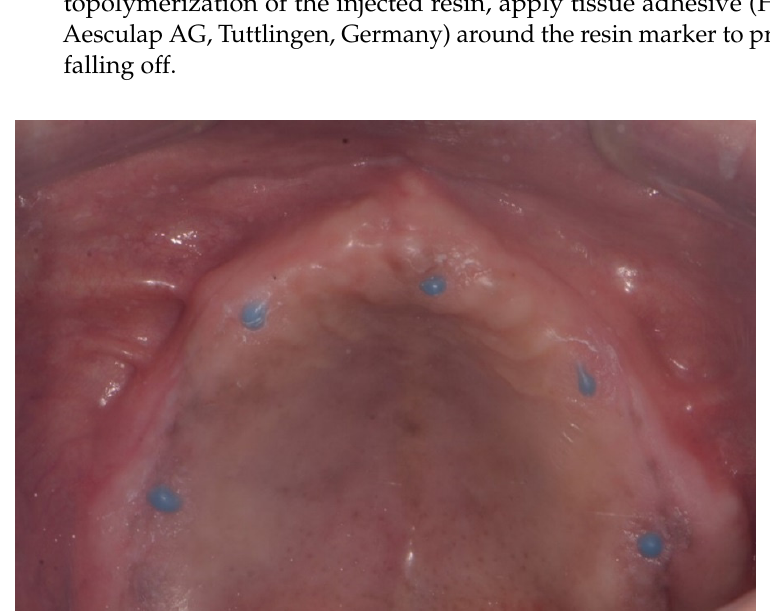
Figure 1. Radiopaque and flowable composite resin on the maxillary mucosa.